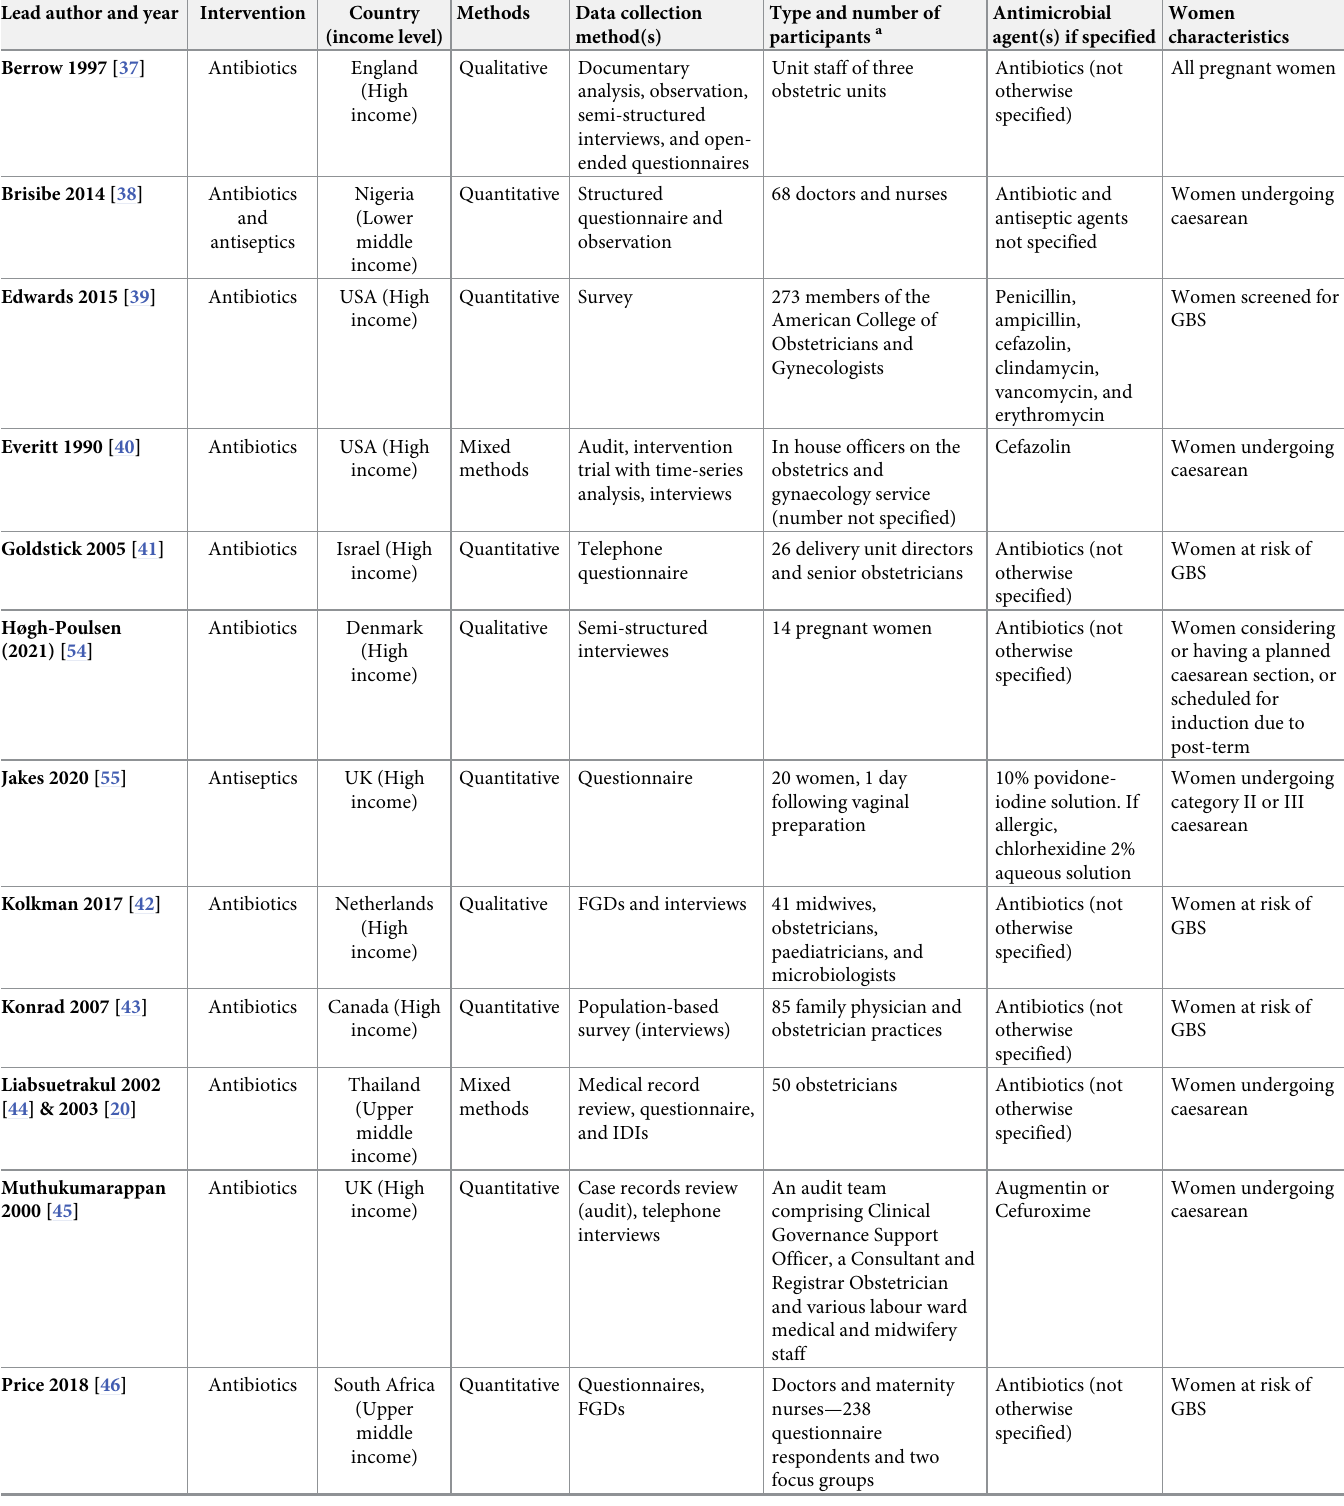
Table 1. Characteristics of included